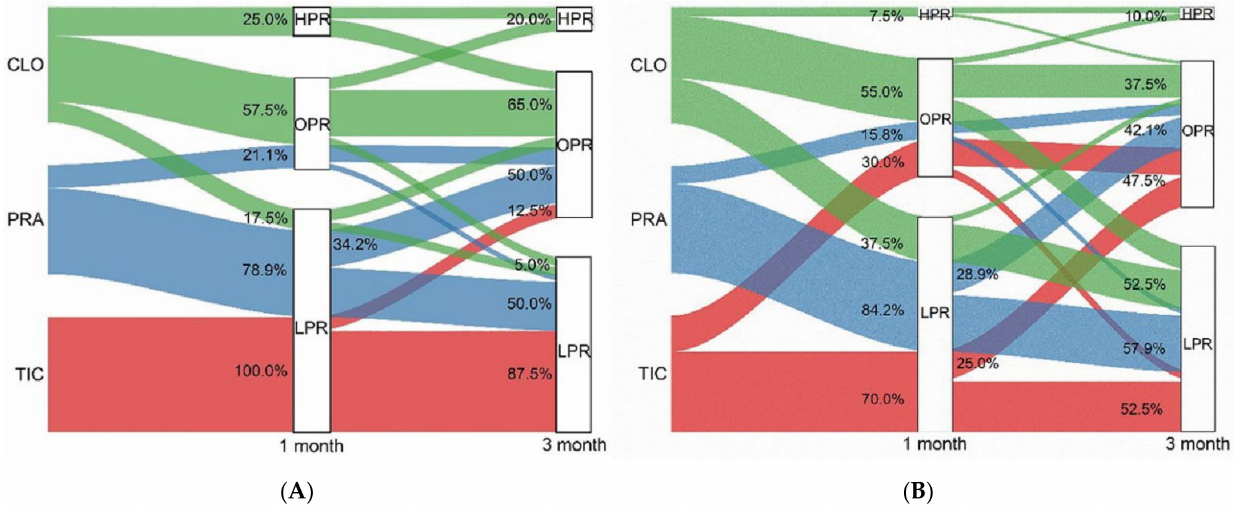
Figure 2. Optimal platelet reactivity rate change from one-month to three-month periods assessed by VN and MEA. Sankey diagram of the relationship between the standard dosage period (1 month)